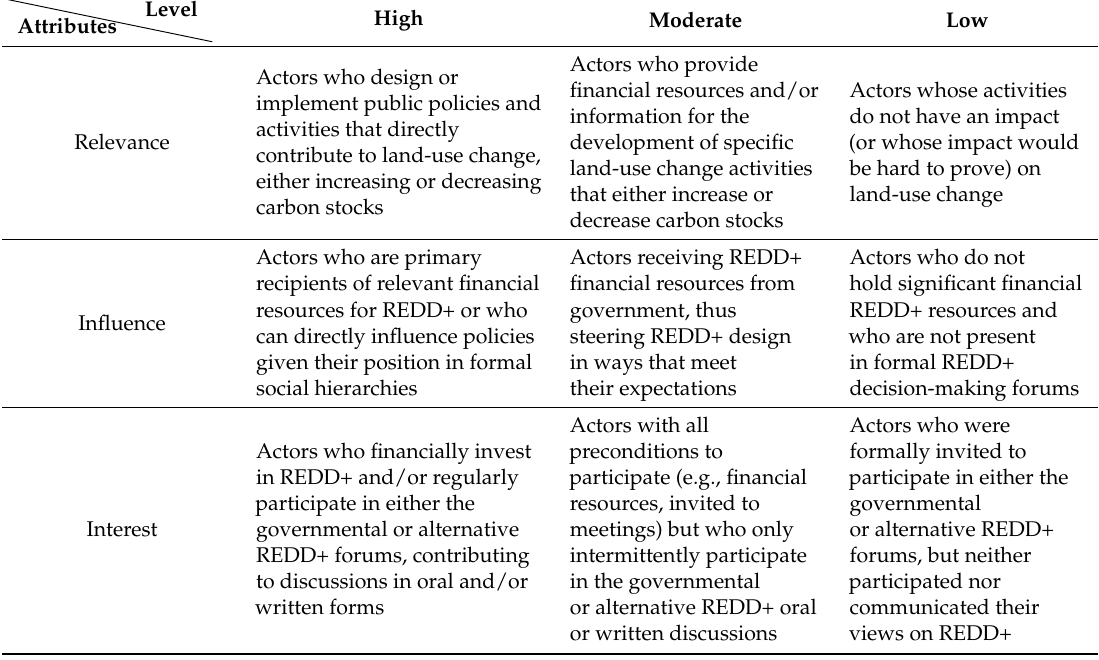
Table 1. Description of actor’s relevance, influence, and interest in REDD+. Source: own